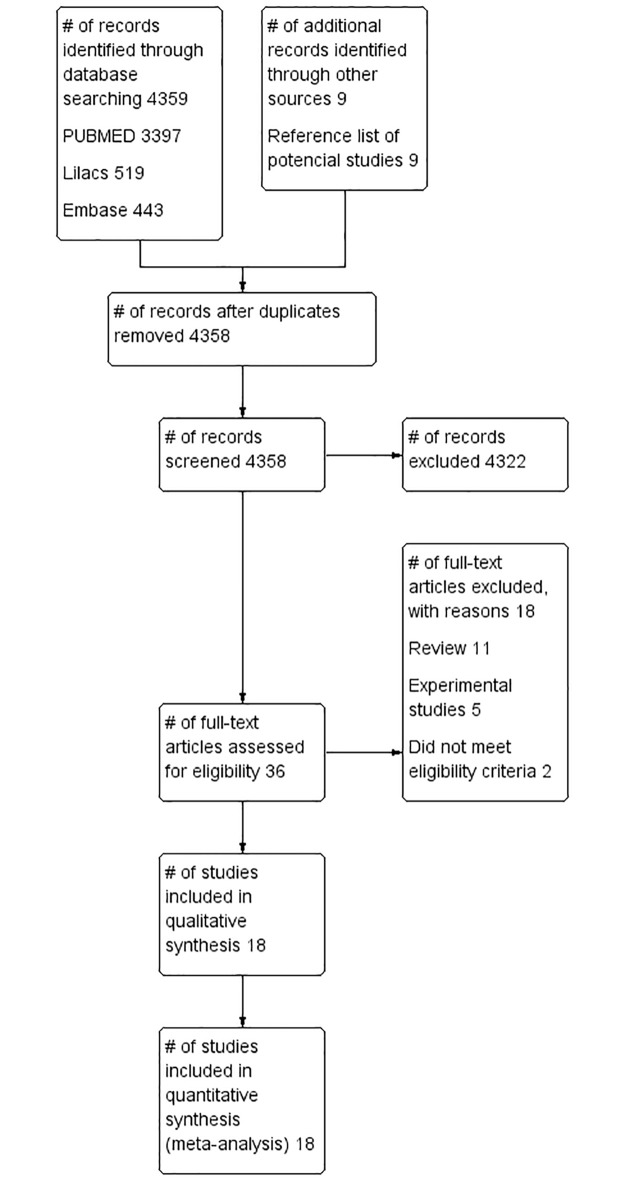
Flowchart of the review.